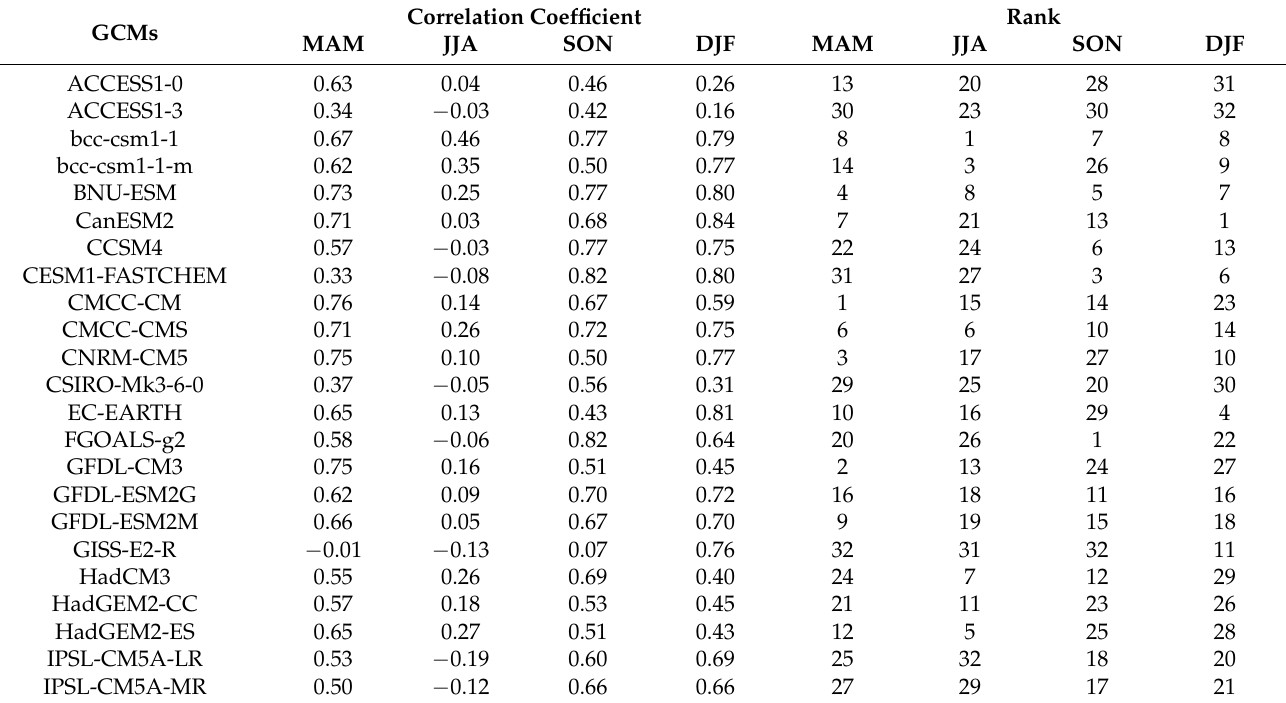
Table 2. Correlation coefficients between node frequencies of 6 × 6 SOMs in the OBS and each GCM, on a seasonal basis. SOMs are given for the temporal SLP anomalies over the